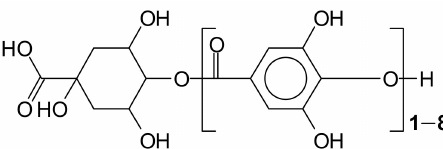
Figure 1. Example of the structures of tara tannin [3,4] and ca ff e-tannins (quinic acid esterified with ca ff eic acids plus glucose